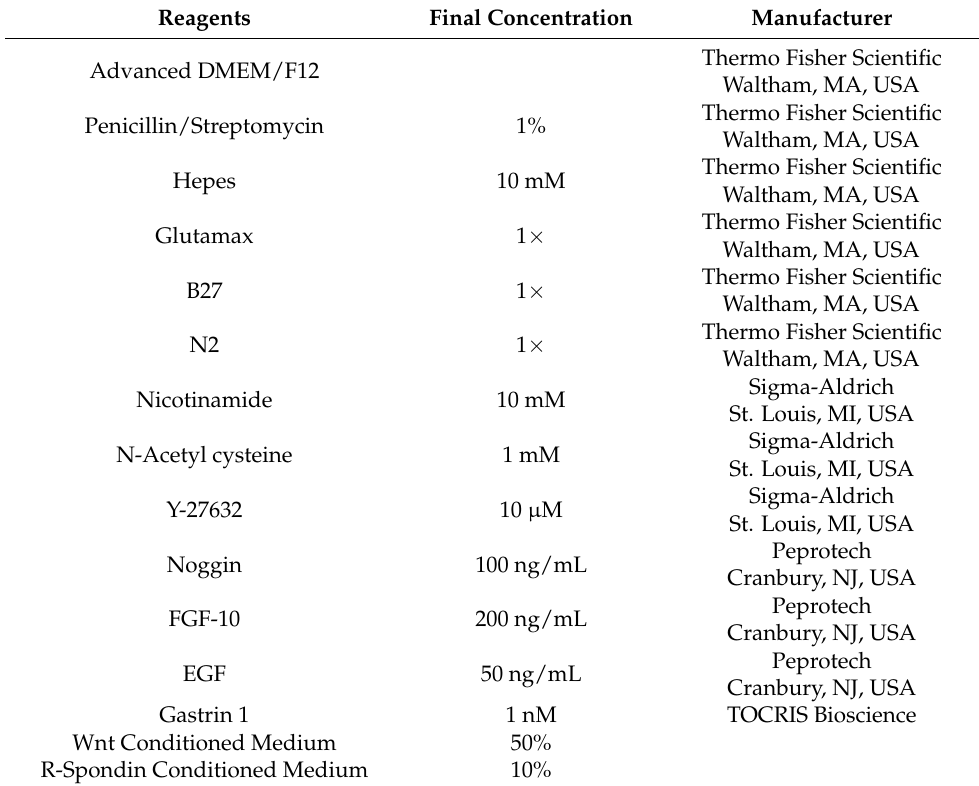
Table 2. Composition of gastric organoid growth